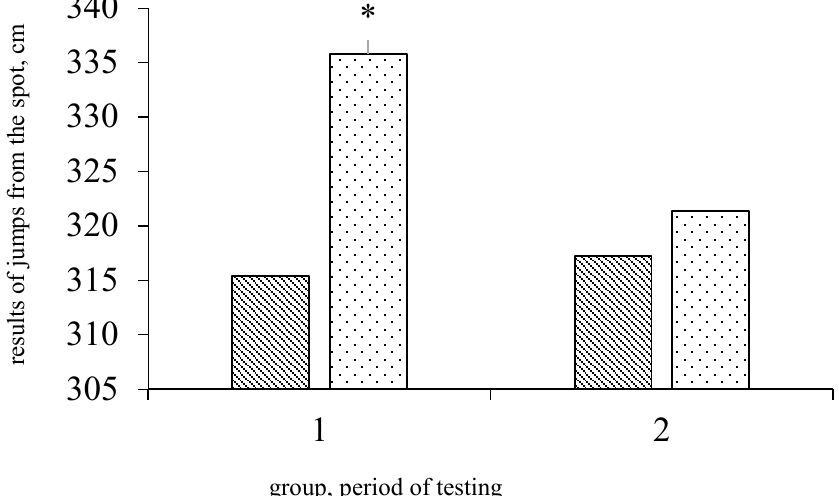
Fig. 2. Results of test “Long jump from run” of experimental (n=34) and control (n=34) groups before and after experiment: